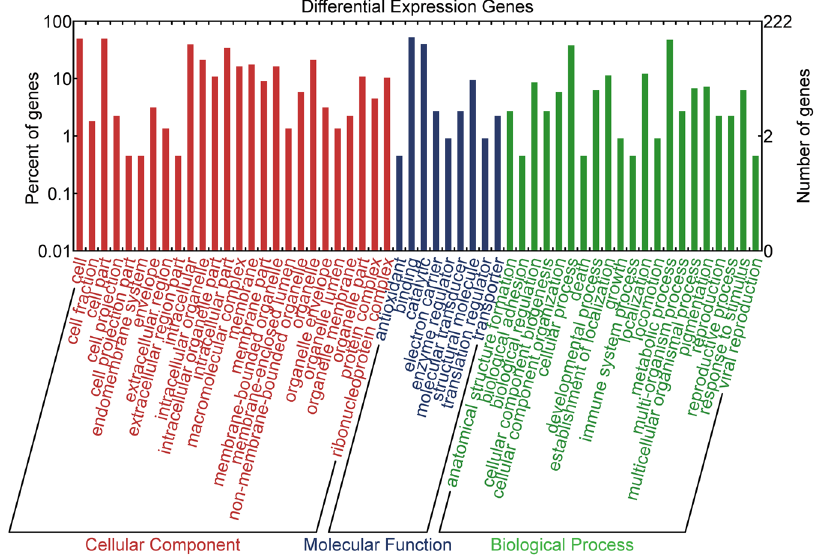
Figure 10. GO Annotation analysis of differentially expressed mRNAs in healthy and diseased (undergoing bleaching) P . caribaeorum